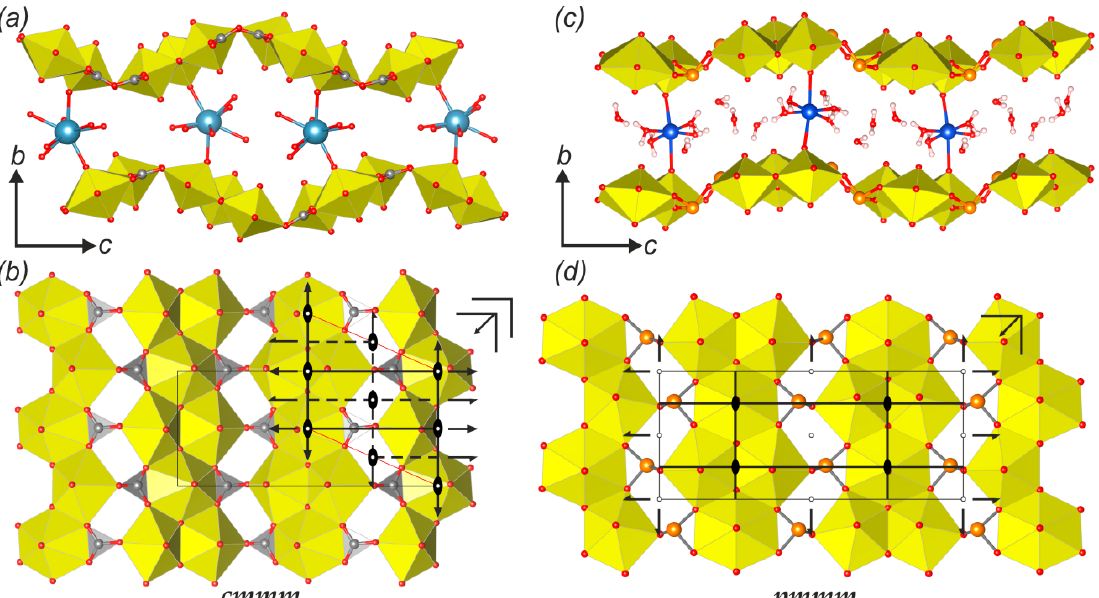
Figure 8. The crystal structures of fontanite ( a ) and marthozite ( c ), uranyl carbonate ( b ) and uranyl selenite ( d ) layers of phosphuranylite topology in their structures, and respective topological symmetry groups. Legend: see Figures 1 and 7.